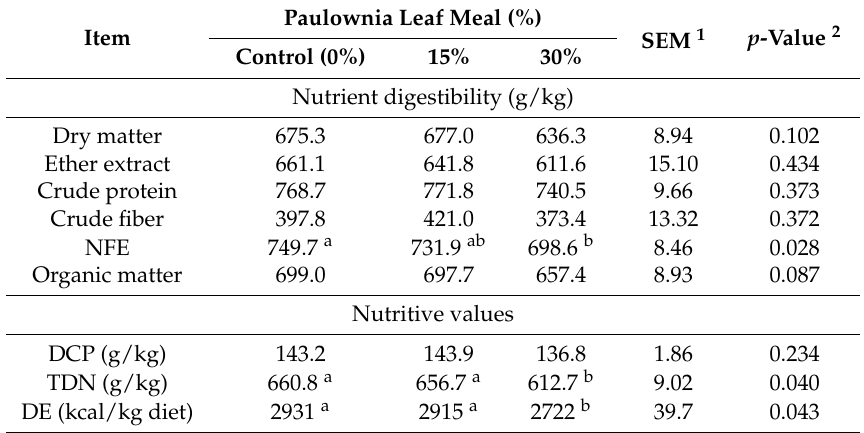
Table 5. Effects of the tested diets on apparent nutrient digestibility and nutritive values of growing New Zealand White